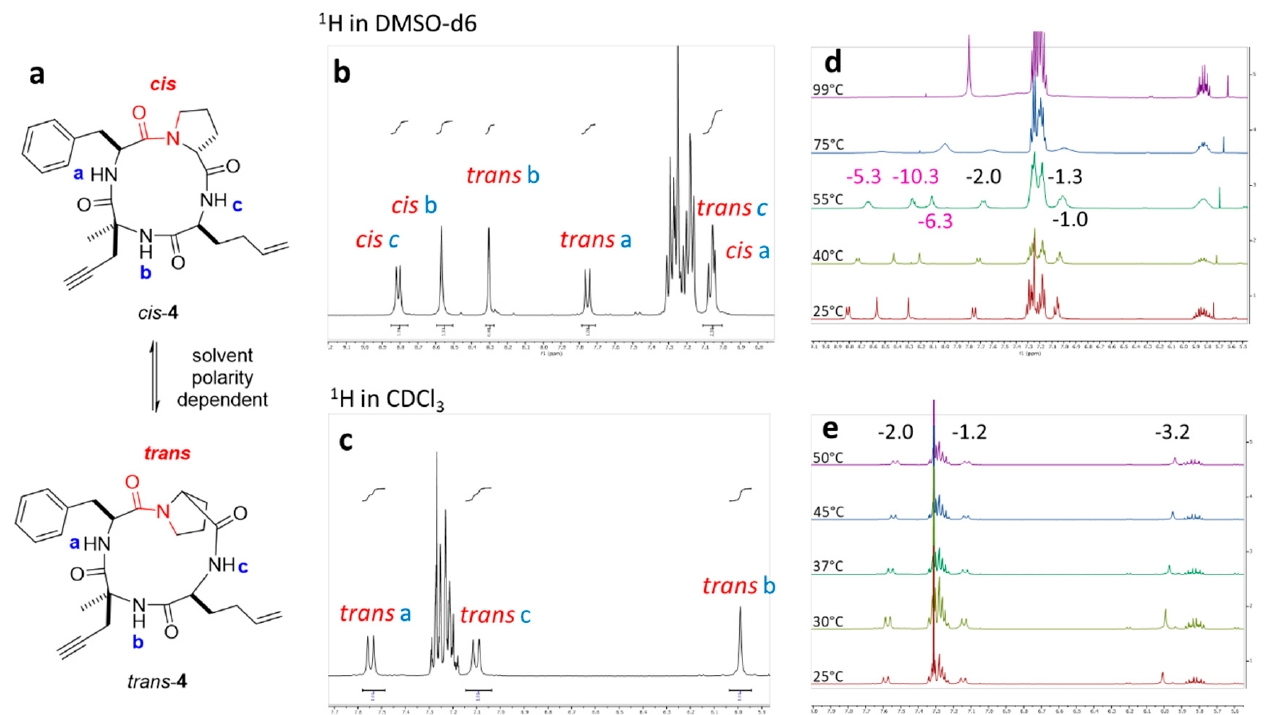
Figure 6. ( a ) Cyclic tetrapeptide 4 underwent proline cis / trans isomerization depending on the polarity of the media. In red, representation of the amide bond between the proline and the phenylalanine in trans and cis conformations; ( b ) and ( c ) 1 H NMR amide protons of 4 in DMSO and CDCl 3 , respectively; ( d ) and ( e ) Temperature shift experiments of 4 in DMSO and CDCl 3 , respectively, with the Tc value in cyan higher than 4 ppb/K.